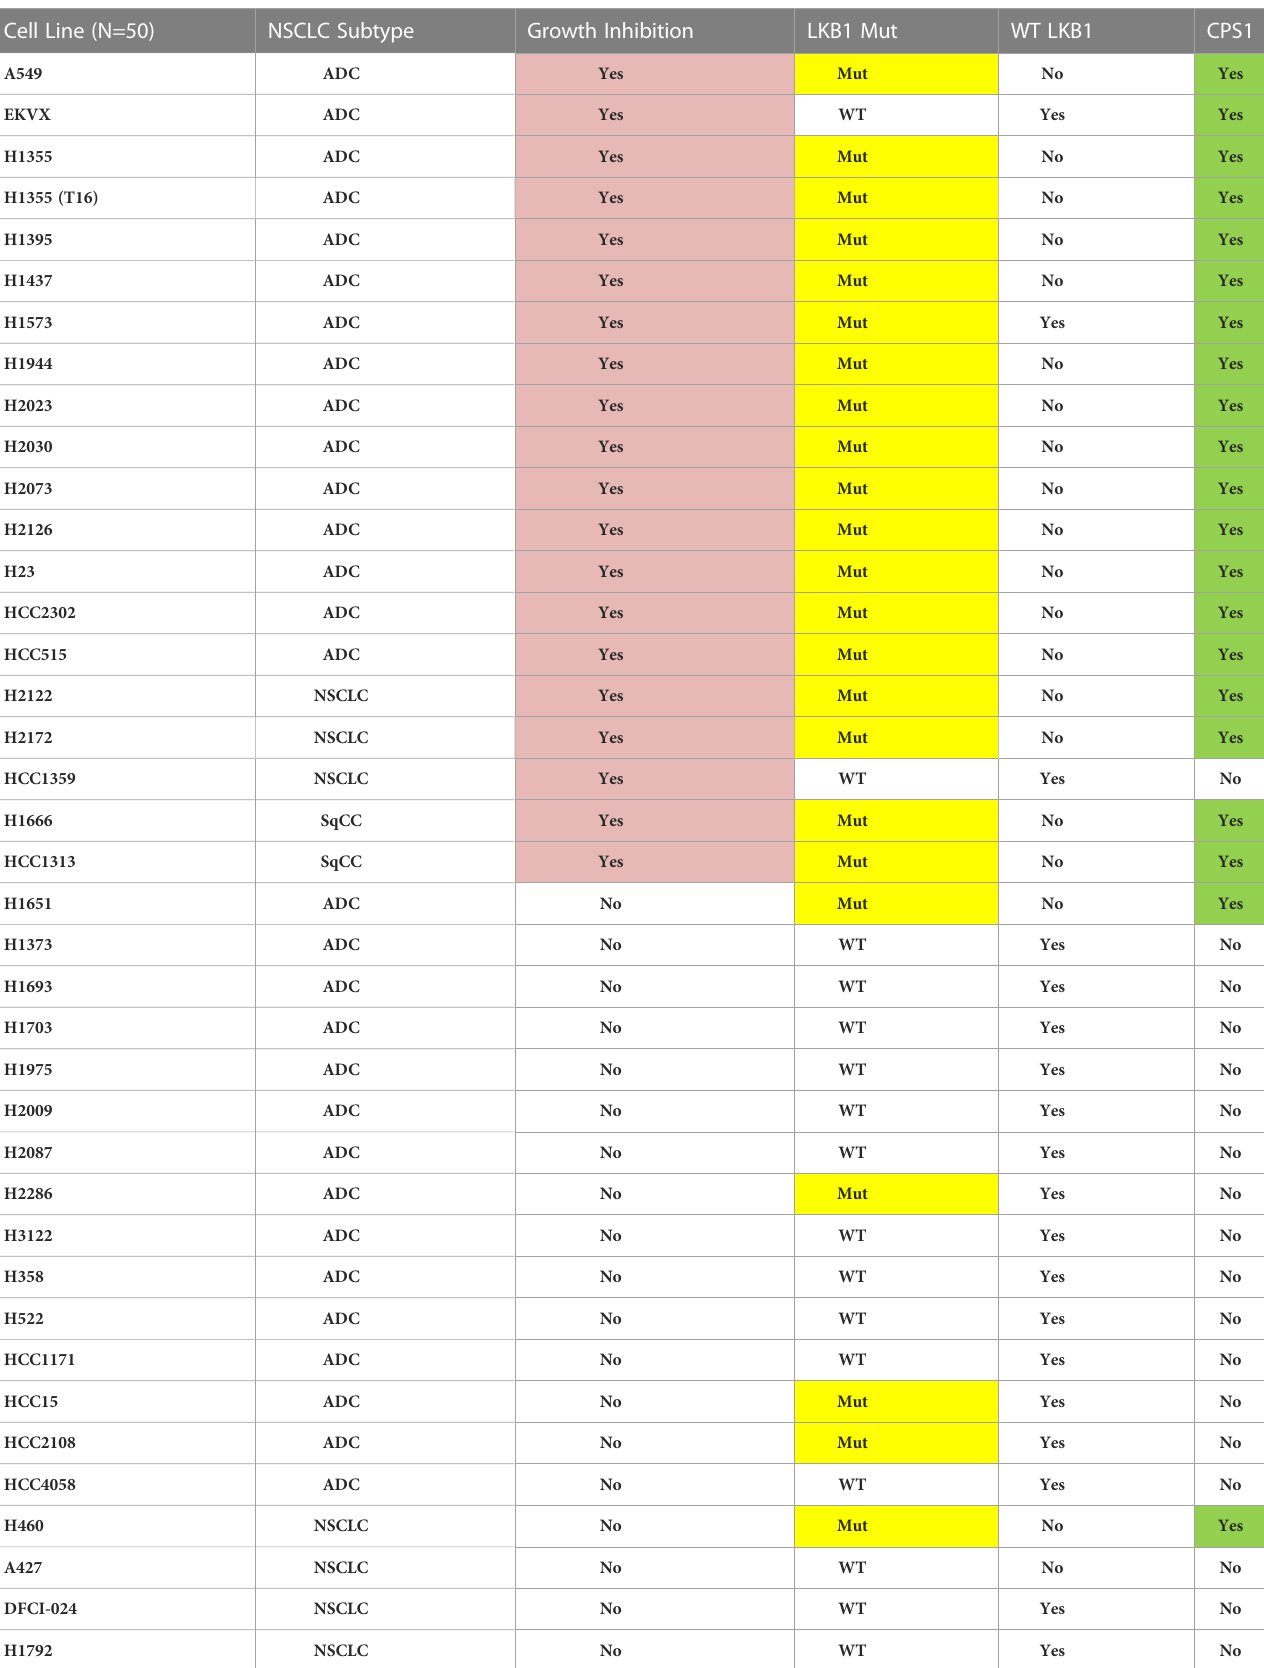
TABLE 1 Summary of results from colony formation assays with 50 NSCLC cell lines after DEX treatment examining growth inhibition, morphology change, mutation status of LKB1 (NGS and western blot) and presence of CPS1 (western blot). Cell Line